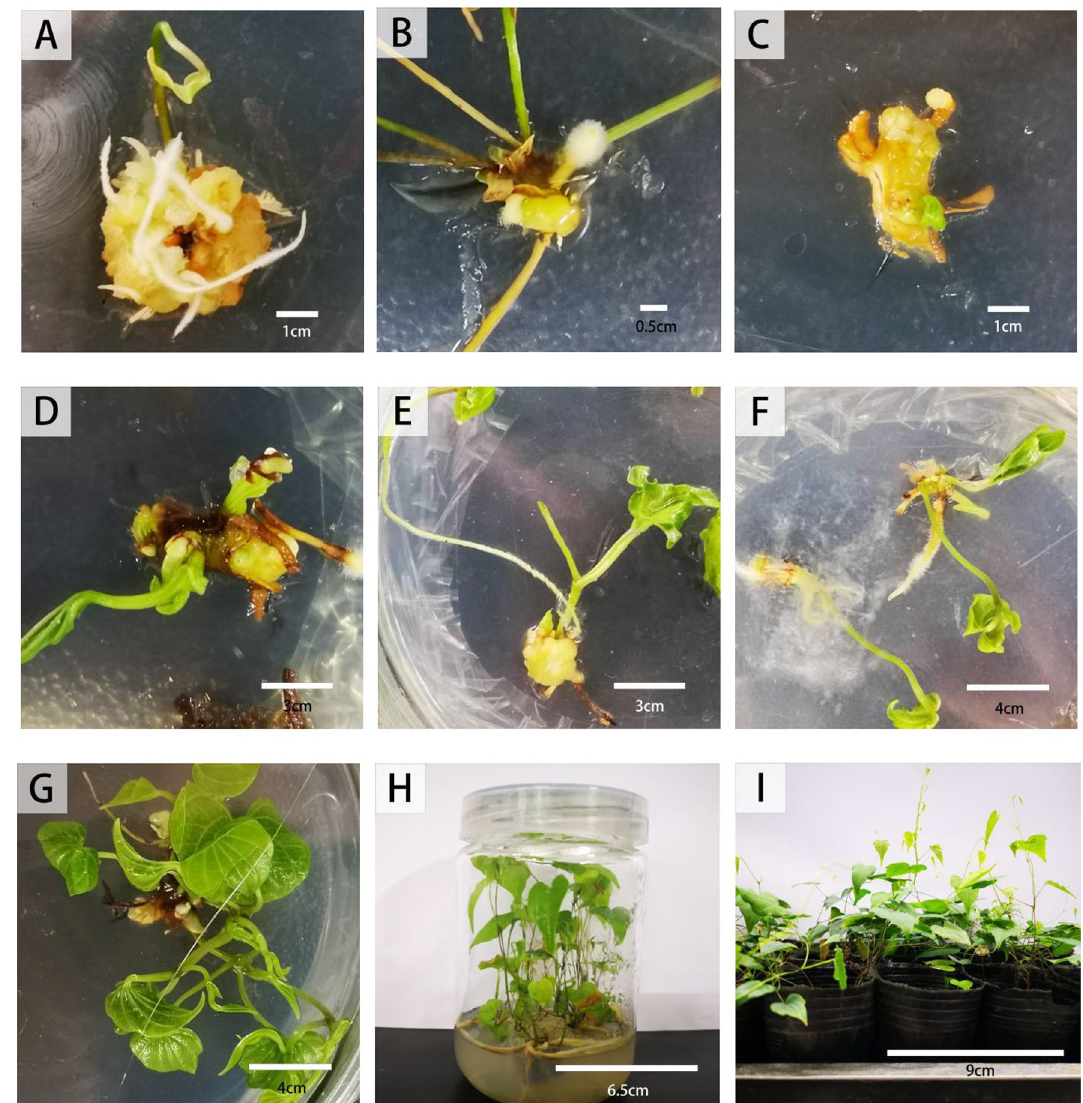
Figure 4. In vitro regeneration from D. nipponica . ( A – C ) presented callus formed by seed, stem segment, and rhizome explants, respectively; D and E presented shoot initiation of rhizome-induced callus, the ( D ) presented the combination of 3.0 mg L −1 6-BA + 2.0 mg L −1 NAA induced shoot, the ( E ) presented the combination of 3.0 mg L −1 6-BA + 1.0 mg L −1 NAA induced shoot; ( F ) presented hairy roots of adventitious buds; ( G ) presented elongation and multiplication of regenerated shoots; ( H ) presented rooting of shoots; ( I ) presented regenerated plant transferred to nutrient tracheids, meristematic cells gathered in clusters on the surface and interior of the callus. Contrasted to the callus type I and II, the cell differentiation ability of callus type III was the strongest, and the cells were most closely arranged (Fig. 5F).